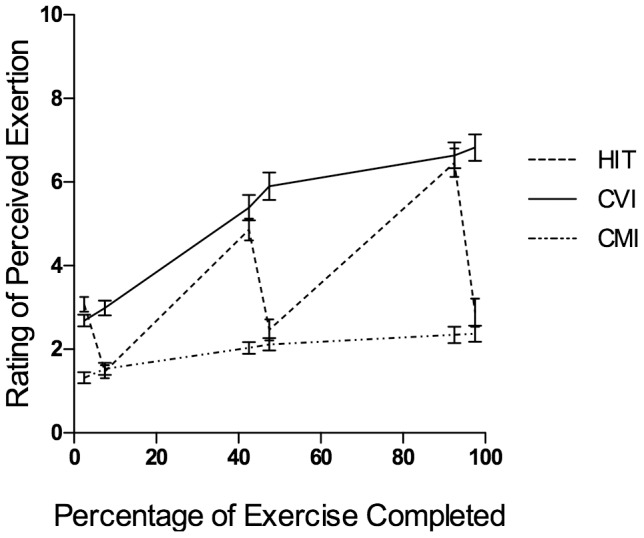
Rating of perceived exertion (M±SE) during the three exercise trials.